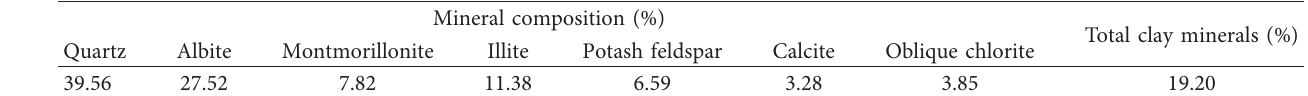
Table 2: Expansive soil mineral composition.